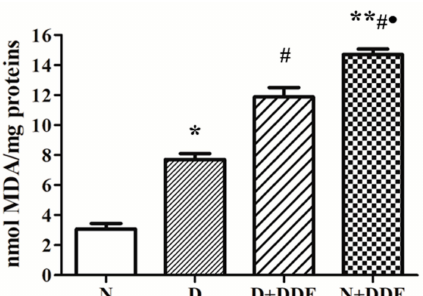
Figure 1. Analysis of malondialdehyde (MDA) accumulation in rat testis homogenate. The